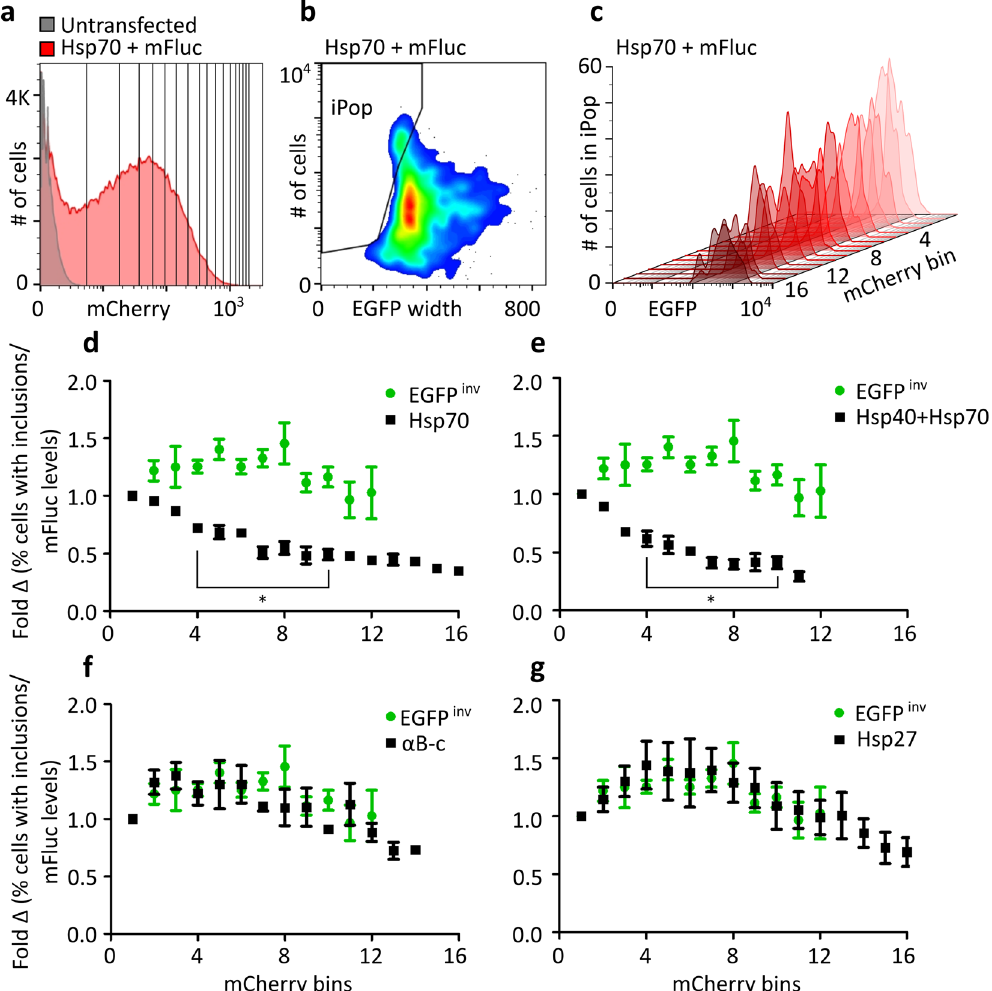
Figure 4. Use of bicistronic constructs to determine the effect of increasing Hsp levels on the formation of mFluc-EGFP inclusion bodies in cells. ( a ) Gating strategy used to determine the fraction of cells with inclusion bodies as a function of mCherry (Hsp) expression. The frequency histogram of mCherry fluorescence was subdivided into 16 bins of equal mCherry RFU (40 RFU), where bin 1 represents the lowest, and bin 16 the highest level of mCherry expression. Pulse shape analysis was used to obtain ( b ) the proportion of cells with inclusions in each mCherry bin. ( c ) The frequency histogram overlay shows the relative reduction in the number of cells with inclusions with increasing mCherry reporter protein, using the mCherry binning strategy. Neuro-2a co-transfected to express Hsp70 with mCherry and mFluc-EGFP are shown in these representative plots. ( d,g ) Fold change in cells with inclusions as a function of mCherry fluorescence (normalised to mFluc- EGFP levels) when transfected with EGFP inv and ( d ) Hsp70, ( e ) Hsp40 and Hsp70, ( f ) αB-c, and ( g ) Hsp27- encoding bicistronic constructs. Mean ± SEM of three biological replicates. Statistically significant differences between the means of cells expressing EGFP inv and Hsp were assessed at each mCherry bin using a student’s t-test where * p < 0.05 was considered significant. mCherry bins with less than 100 events were excluded from subsequent